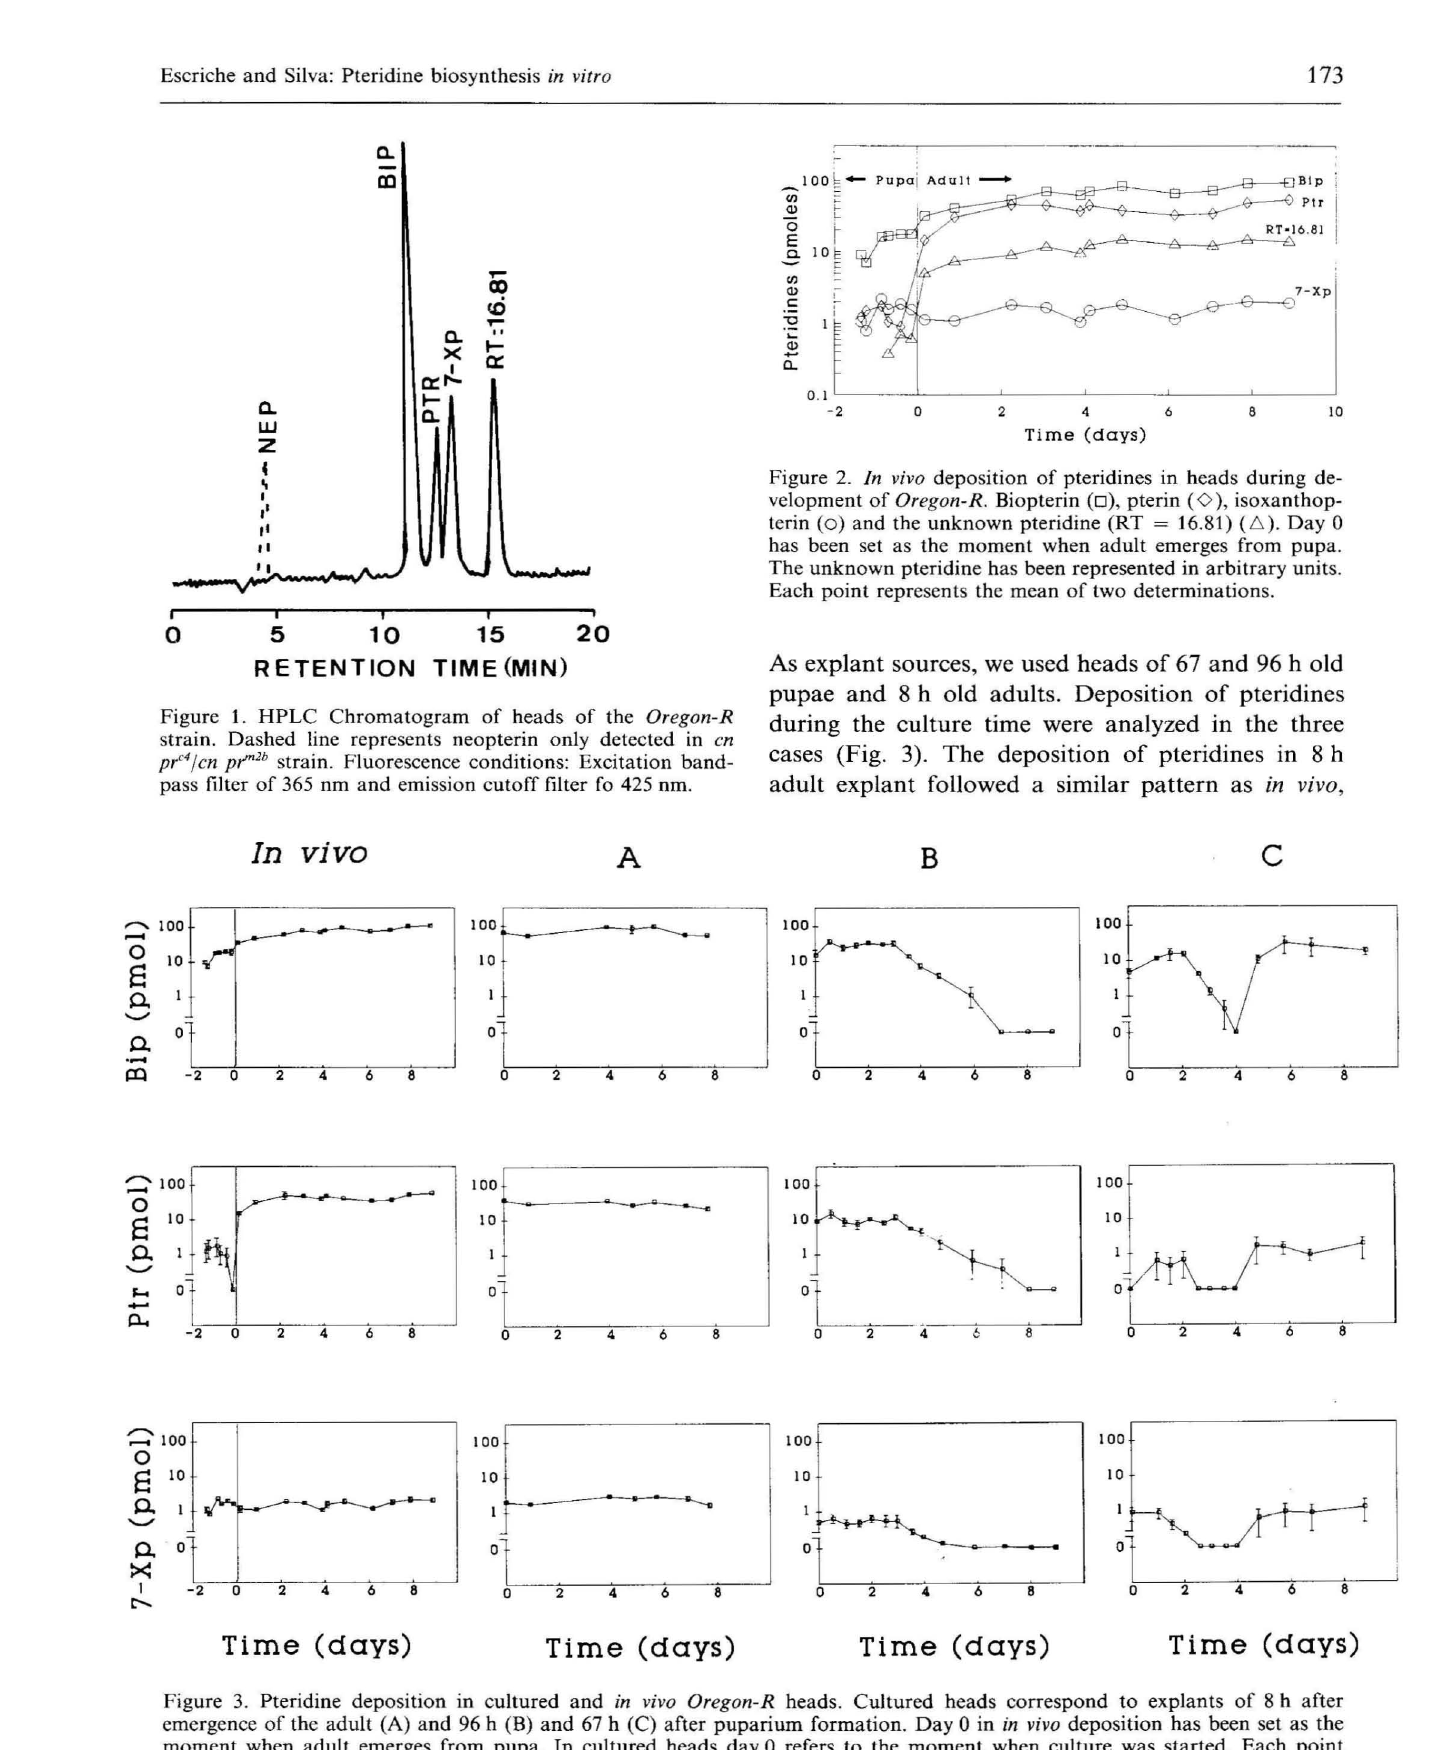
Pteridines / Vol. 3 /